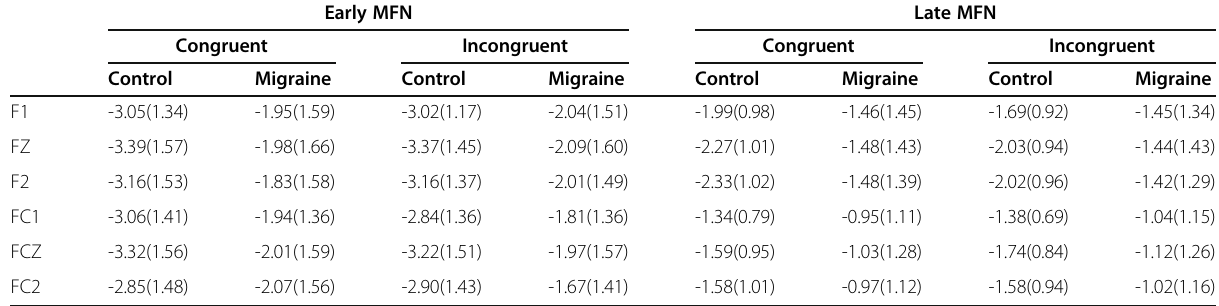
Table 3 MFN mean amplitudes during the congruent and incongruent conditions at six midline frontal electrodes (F1, FZ, F2, FC1, FCZ, FC2) Early